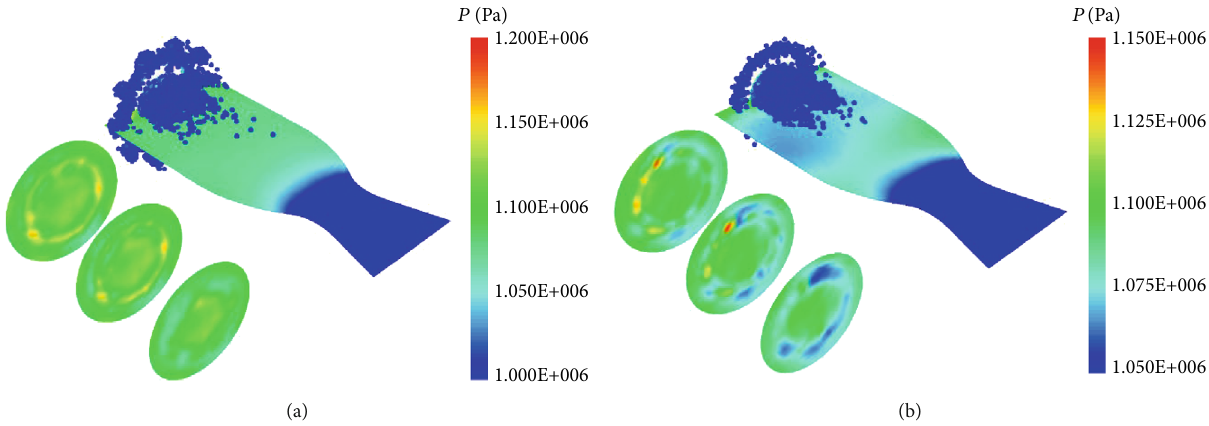
Figure 16: The acoustic pressure contours in Case 4. (a) 8.0647ms, MMH. (b) 9.27406ms, NTO.